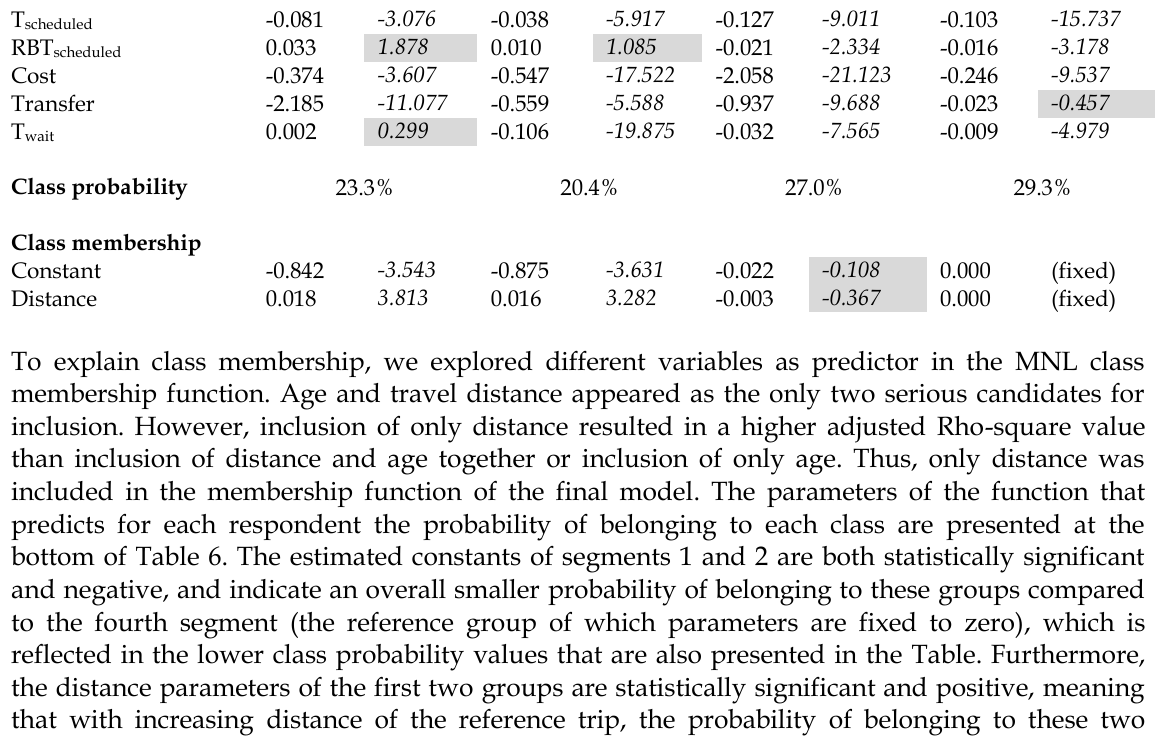
Table 6. The estimated parameters of the segments of model 2c (RBT SCHEDULED ) 1. "Transfer 2. "Waiting time 3. "Cost sensitive" 4. "Time sensitive" sensitive" sensitive" Par. t-ratio Par. t-ratio Par. t-ratio Par.